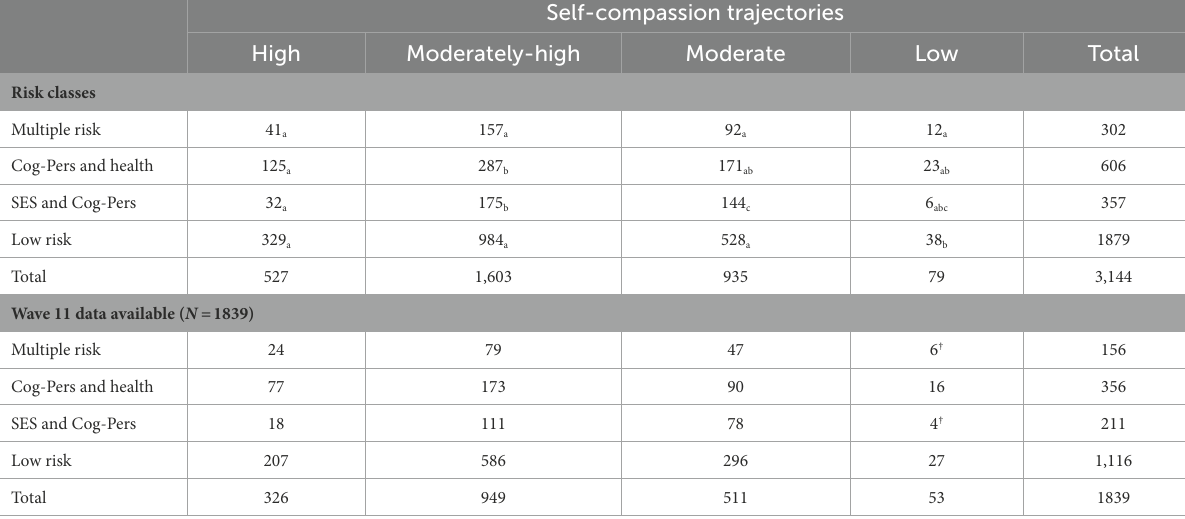
TABLE 6 Sample sizes across cells, risk class by self-compassion trajectory profile.